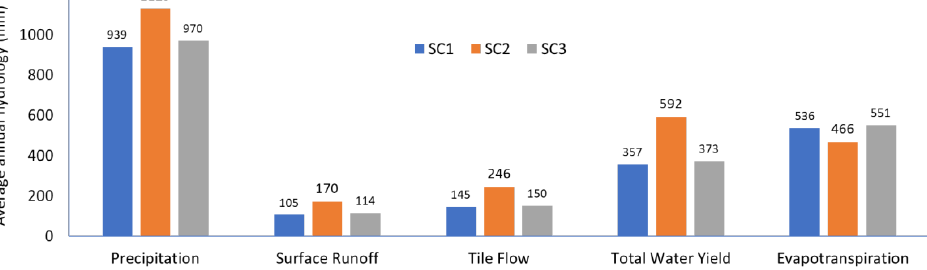
Figure 5. Comparison of different weathers scenarios (SC1 (GCDC), SC2 (CFSR) and SC3 (measured)) in terms of hydrological budgets with combination of SLC (soil) and Solaris (land use).